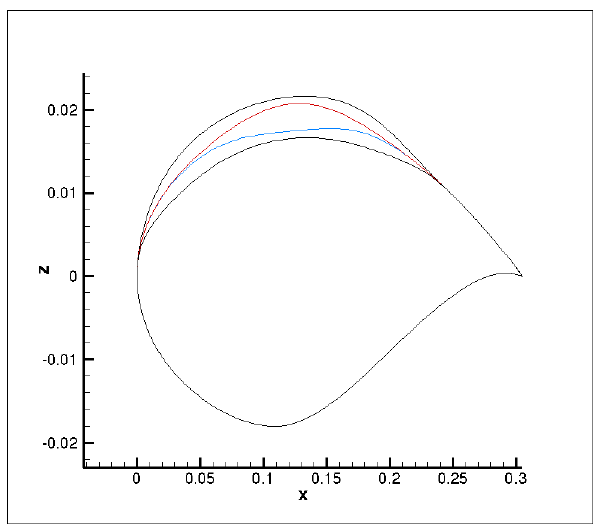
Figure 7. Black lines: Maximum and minimum deformation of the RAE2822 profile. Red: Maximum deformation of the third bump alone. Blue: Minimum deformation of the third bump alone. This image is taken from Dumont et al. [12].